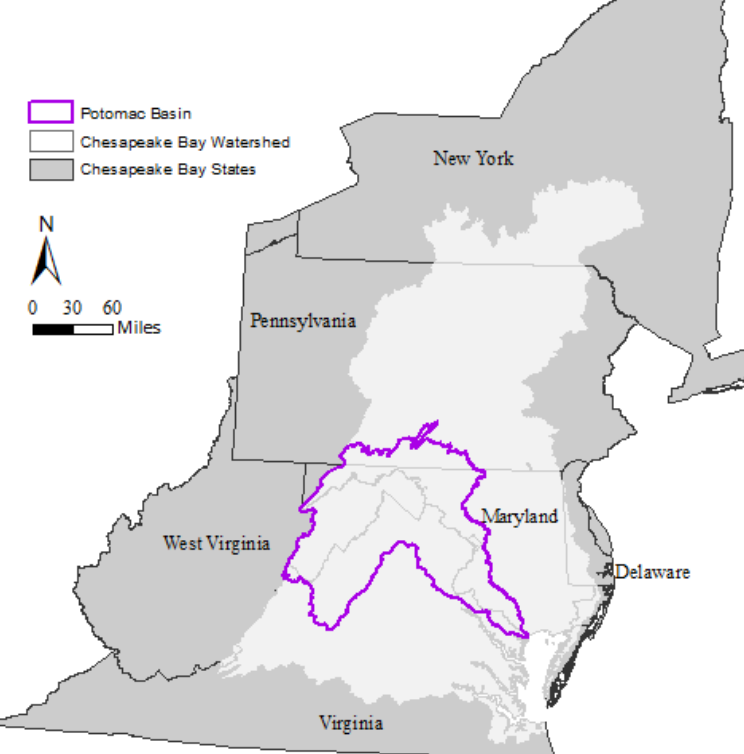
Figure 1. Location of the Potomac basin in the Chesapeake Bay watershed, Chesapeake Bay states, and the District of Columbia.